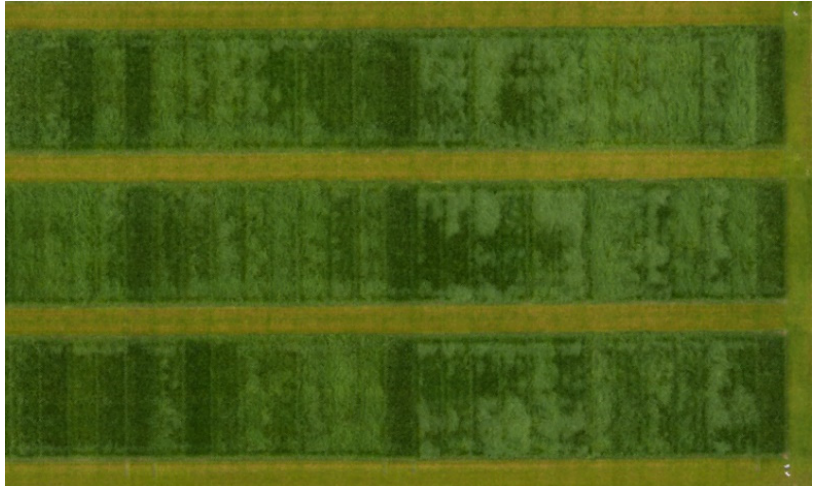
Figure 6. Close-up view of bending plots for some tetraploid varieties just before the first spring